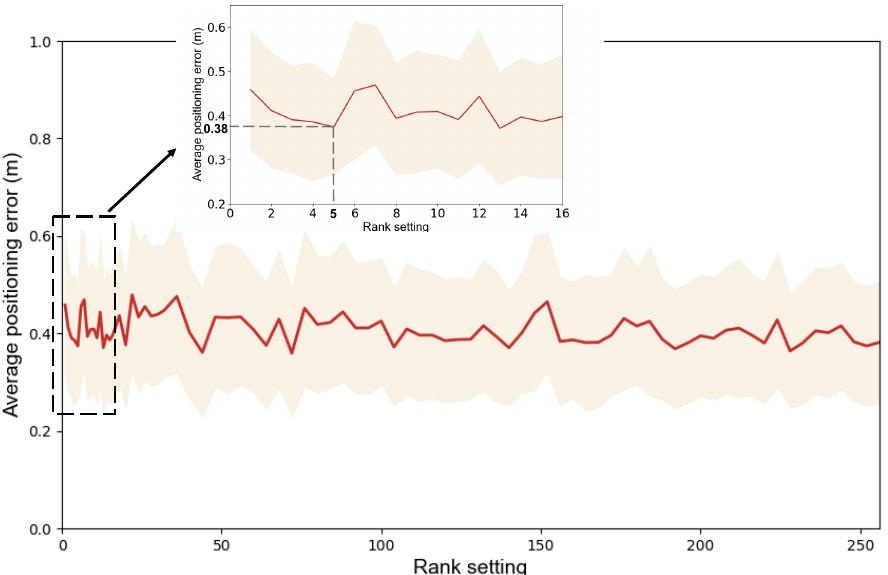
Figure 12. The impact of different rank settings on positioning performance. We select different verification intervals in different ranges of rank, with intervals of 1 in [1, 16], 2 in [16, 32], and 4